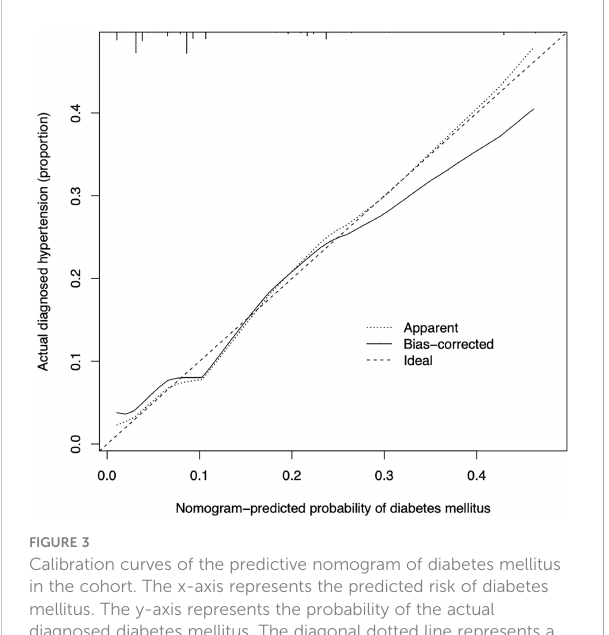
FIGURE 3 Calibration curves of the predictive nomogram of diabetes mellitus in the cohort. The x-axis represents the predicted risk of diabetes mellitus. The y-axis represents the probability of the actual diagnosed diabetes mellitus. The diagonal dotted line represents a perfect prediction by an ideal model. The solid line represents the performance of the nomogram, of which a closer fi t to the diagonal dotted line represents a better prediction.